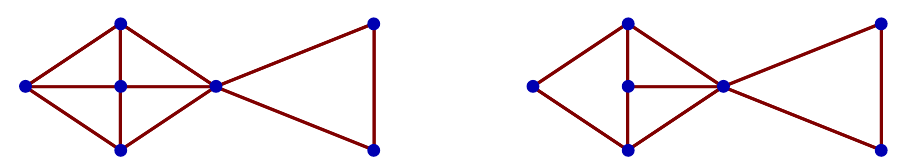
Figure 10 . “Fish” graphs — representatives from two classes of T-dual codes, which share the same refined enumerator polynomial (6.38); they are C-equivalent but not T-dual to each other. The first class includes 10 distinct non-isomorphic graphs; the second class includes 9 . We choose among them two representatives based on simplicity and aesthetics. These two classes of graphs also share the interlace polynomial Q = 30 x 7 + 58 x 6 y + 34 x 5 y 2 + 6 x 4 y 3 . It turns out, there are exactly two distinct classes of T-equivalent codes for n = 7 which share the same